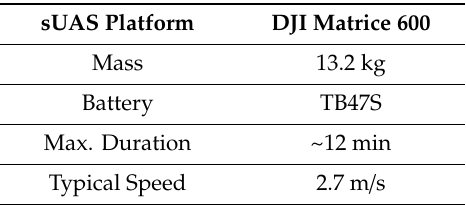
Figure 2. Illustration of sensor mounting to sUAS. Table 1. Flight specifications of sUAS with methane sensor. Table 1. Flight specifications of sUAS with methane sensor.